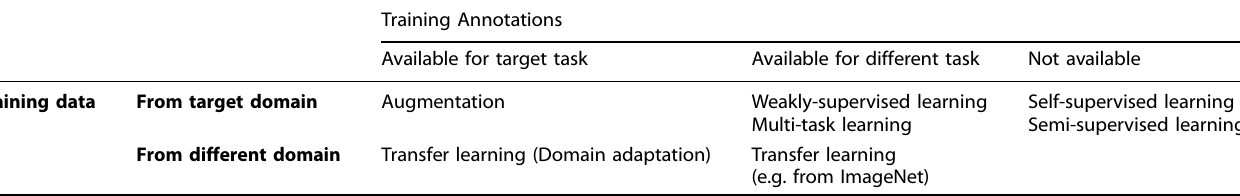
Table 1. Common approaches to reduce annotation dependency when learning to perform a task (target task) in a speci fi c domain (target